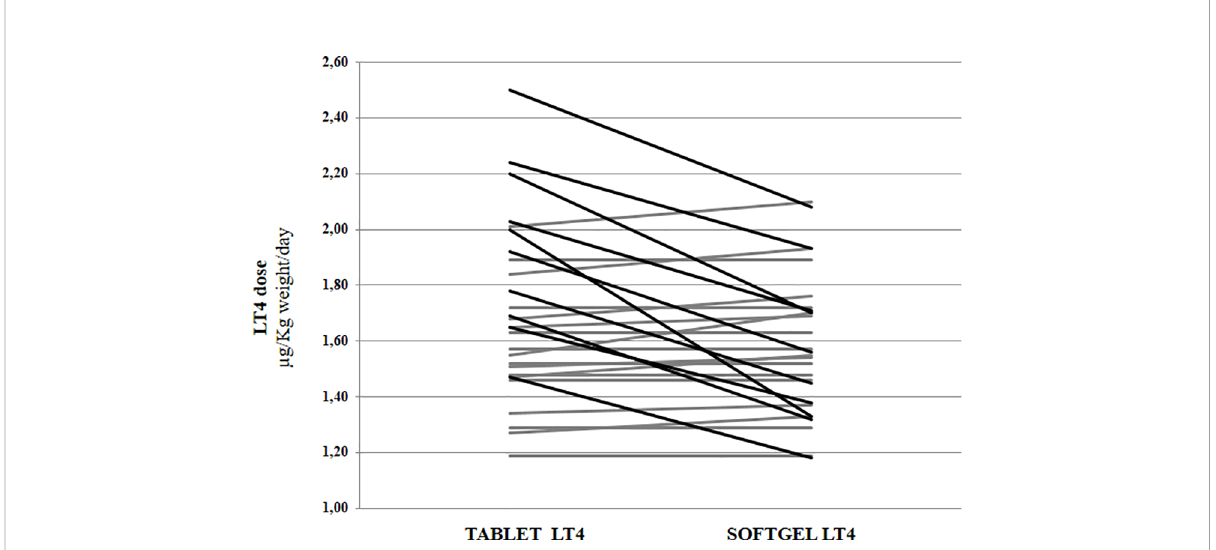
FIGURE 1 Levothyroxine daily requirement in patients treated with tablet preparation and following the switch to softgel formulation. Black lines indicate patients with a reduction of requirement higher than 20%. In grey are indicated patients without a signi fi cant requirement